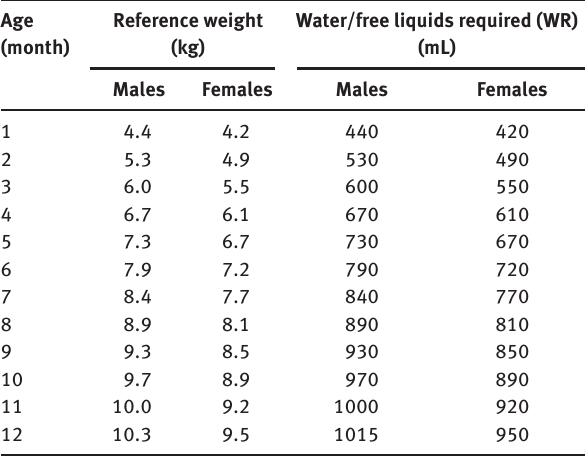
Table 6: Water/free liquids required (WR) according to ages (Fluid Requirements for Children, 2019, available at: